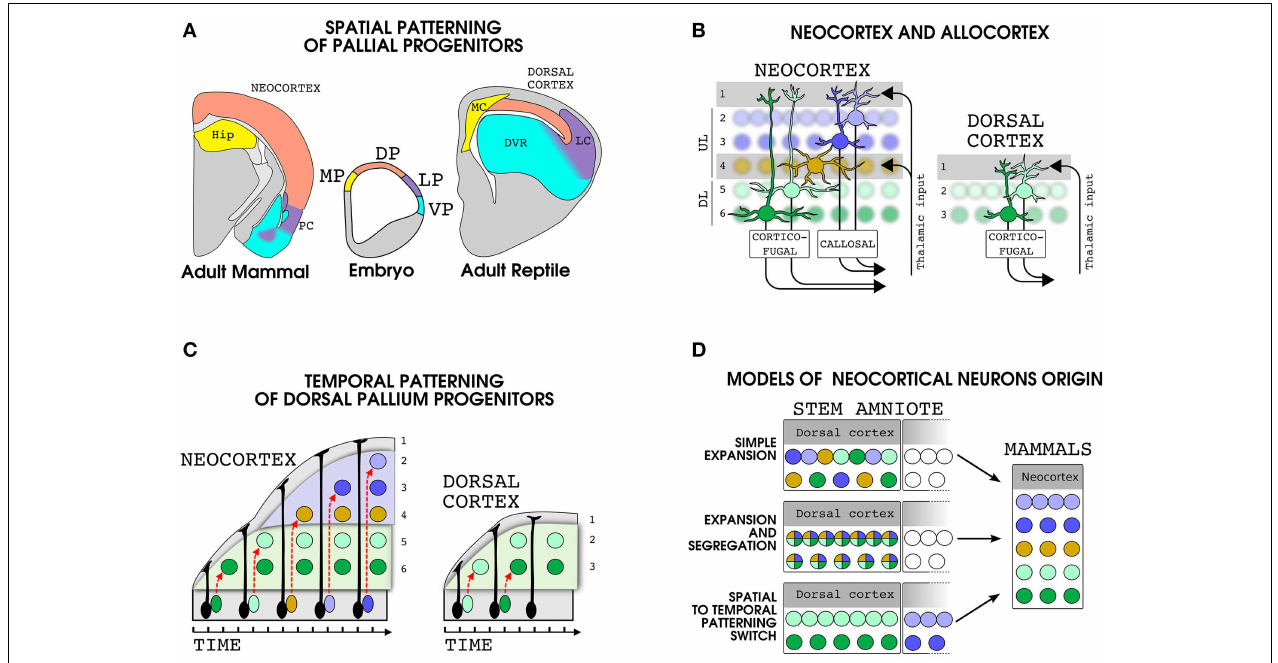
FIGURE 1 | Development and evolution of dorsal pallial derivatives in amniotes. (A) Spatial patterning mechanisms subdivide the embryonic pallial progenitors in at least four domains: Medial pallium (MP, yellow), dorsal pallium (DP, pink), lateral pallium (LP, violet) and ventral pallium (VP, cyan). The brain regions produced by each domain are shown in a mammal (left) and a reptile (right) with the same color code. (B) Schematic representation of the organization of the cellular layers and main input and output projections in the neocortex (left) and in the reptilian dorsal cortex (right). (C) Development of dorsal pallium glutamatergic neurons in mammals and reptiles. In the neocortex the same progenitor produces multiple cell types in an inside-out sequence. In the reptilian dorsal cortex, the dorsal pallium progenitors produce a